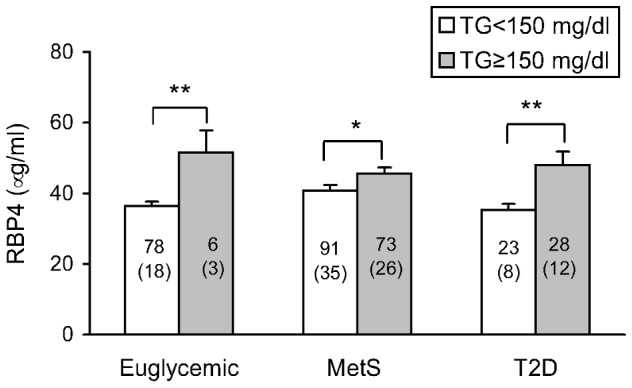
Serum RBP4 levels in euglycemic, metabolic syndrome and type 2 diabetic patients according to optimal or high triglyceride levels.Data are expressed as mean+SEM. Sample size is indicated inside the column and the number of men is indicated in brackets. *p<0.05, **p<0.01 when compared by unpaired T-test optimal versus high triglycerides. A Pearson Chi square test revealed no differences in sex distribution between optimal and high triglyceride levels. Abbreviations: MetS: metabolic syndrome patients; T2D: type 2 diabetic patients.